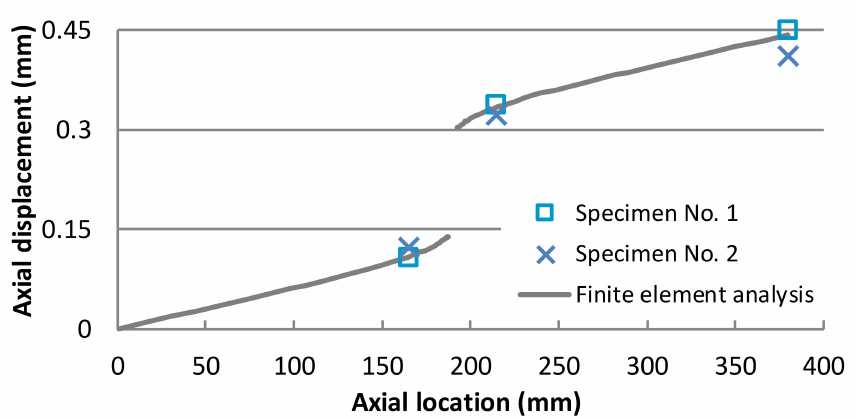
Figure 7. Distribution of displacement along the center line of the specimen where F 0 = 15 kN.